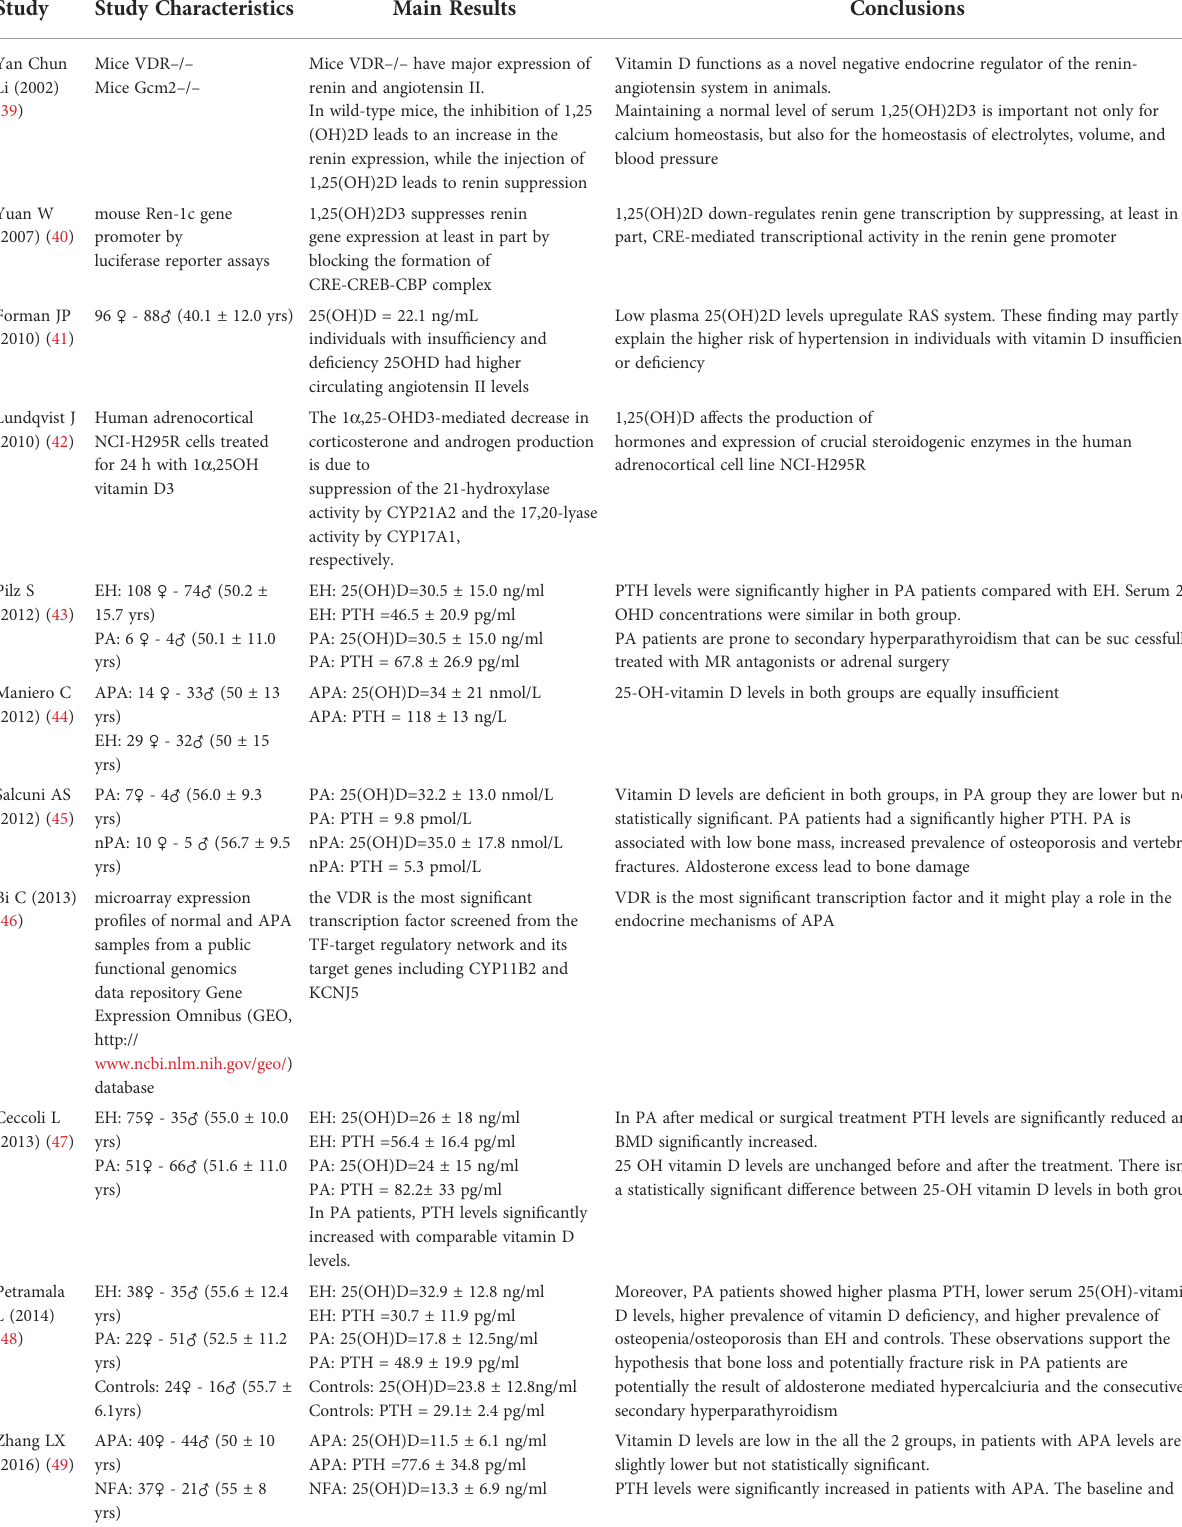
TABLE 3 Main characteristics of the 13 studies included in the review on Hyperaldosteronism.